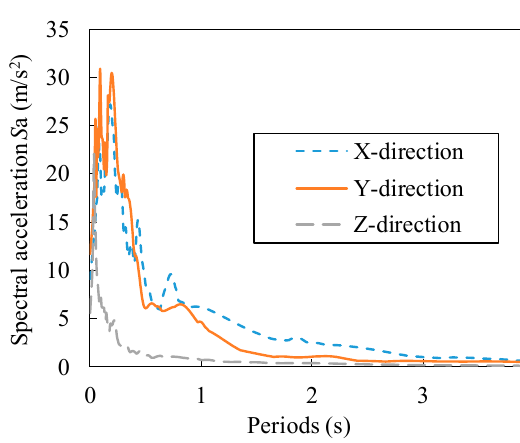
Figure 7. Dimensions and reinforcements of the model structure (units: mm). [ Error! Reference source not found. ] (Reproduced with permission from Huang, Q., from Study on spatial collapse responses of reinforced concrete frame structures under earthquake ; published by Tongji Univerity, 2006.).